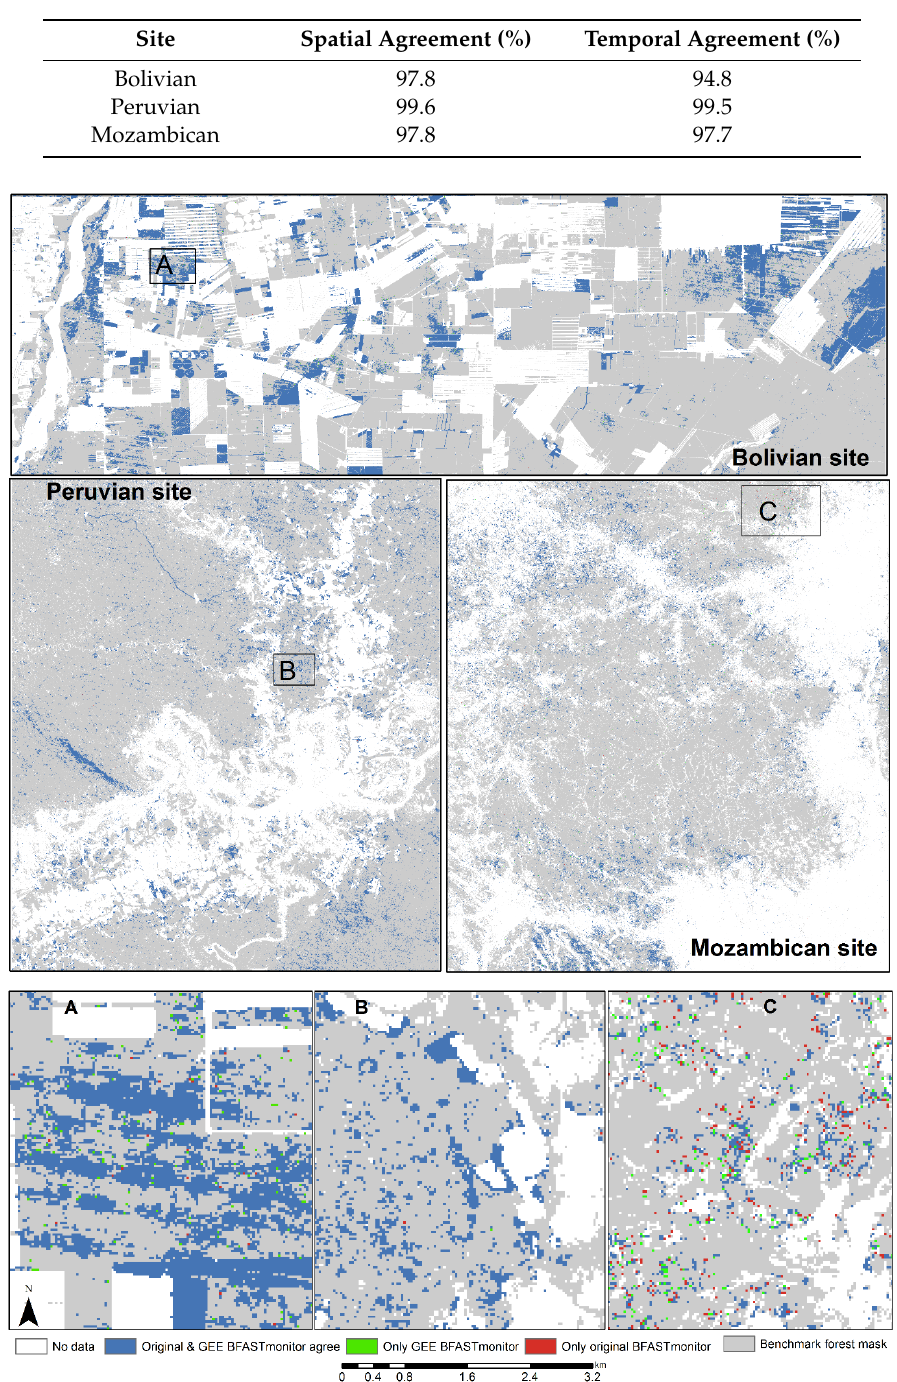
Table 2. Spatial and temporal agreement between original and GEE BFASTmonitor on forest disturbance detected from Landsat NDMI time series at each site.